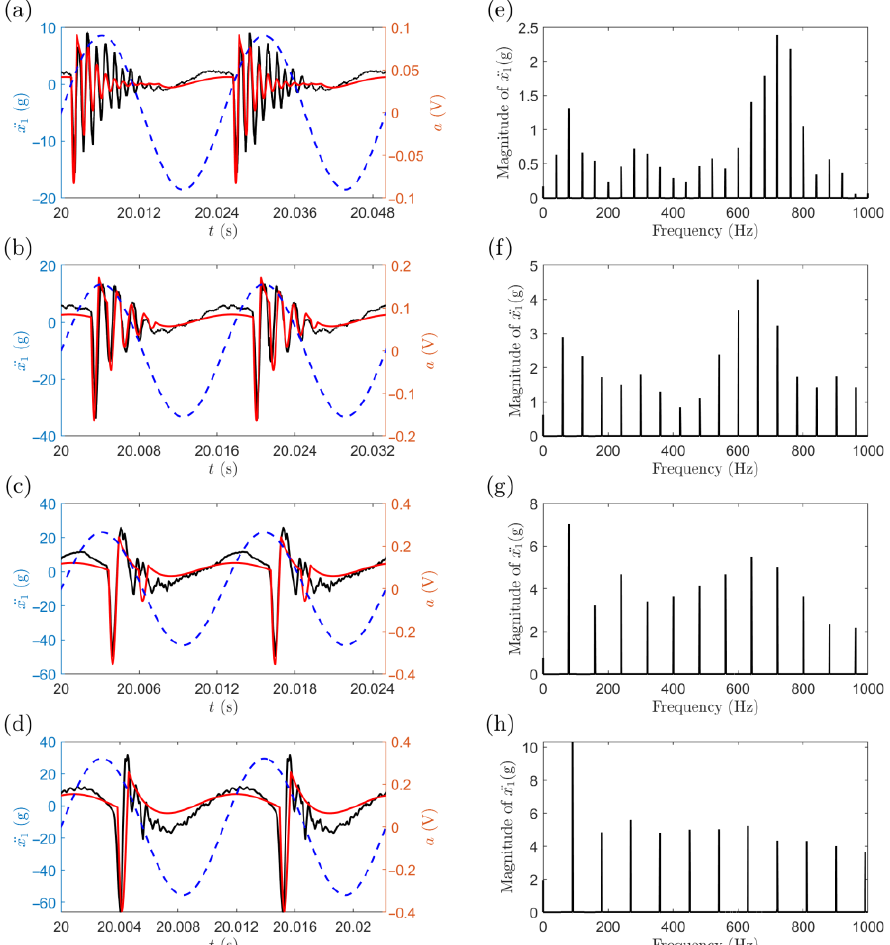
Figure 3. Time histories ( a ), ( b ), ( c ) and ( d ) and FFT ( e ), ( f ), ( g ) and ( h ) of the acceleration of the indenter when the excitation frequencies are 40 Hz ( first row ), 60 Hz ( second row ), 80 Hz ( third row ) and 90 Hz ( last row ) for the metal case. The black line represents experimental results, the red line represents simulation results, and the blue line is the input excitation voltage.